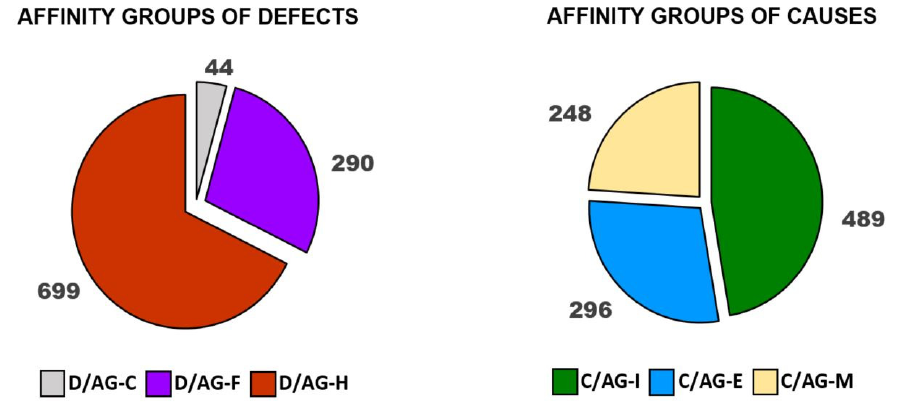
Figure 6. Percentage of presence by type of building.